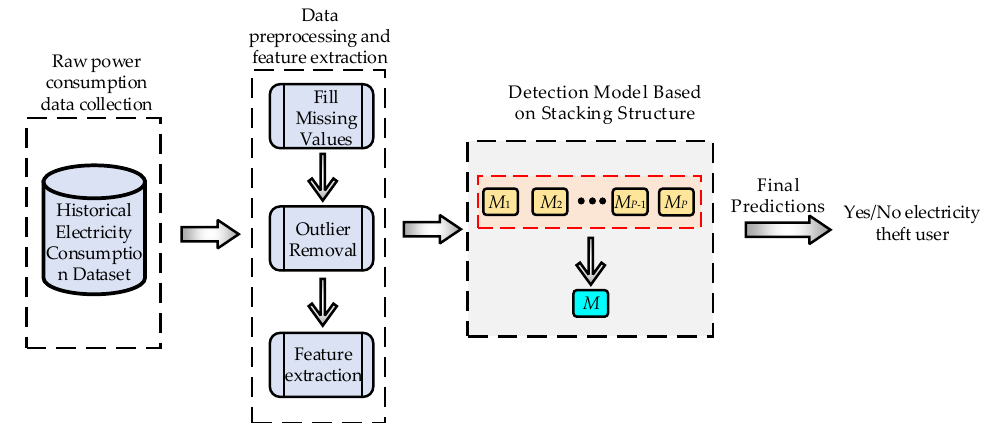
Figure 4. Structure of stacking integrated model experimental flow chart.